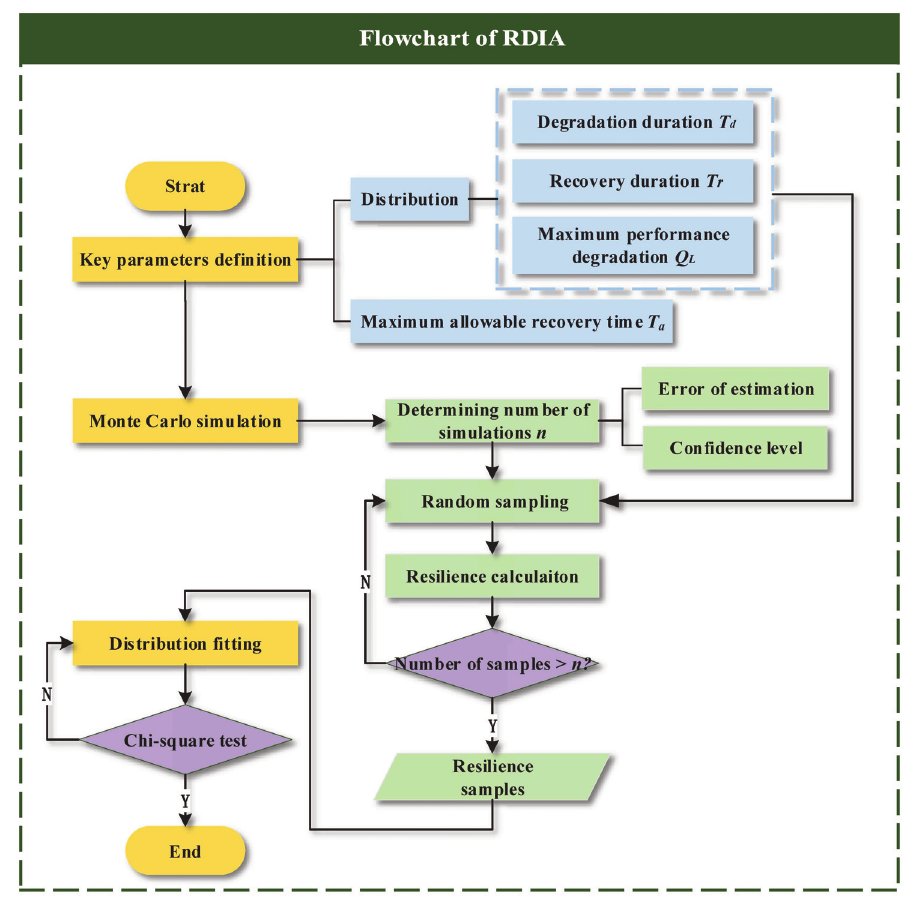
Fig 3. Flowchart of the RDIA